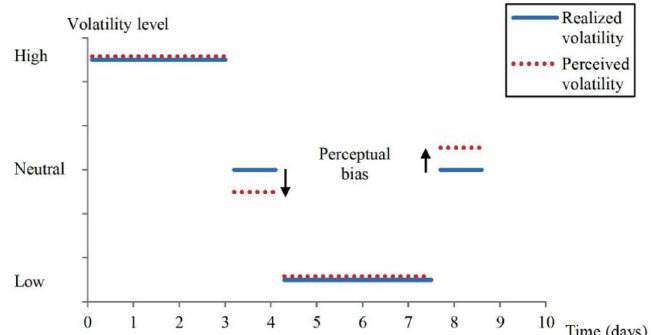
Figure 1. Risk after-effect in the aftermath of a volatility regime in a given financial market. The diagram is a stylized representation of a high volatility regime (top left blue horizontal line), low volatility regime (bottom blue horizontal line), and corresponding transition phase (blue horizontal line following each regime). Recent studies show that perceived volatility (dashed lines) is biased downward (resp. upward) in the aftermath of a high (resp. low) volatility regime 15,16